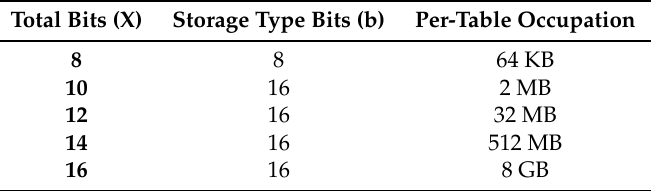
Table 2. Table occupation for various configurations.